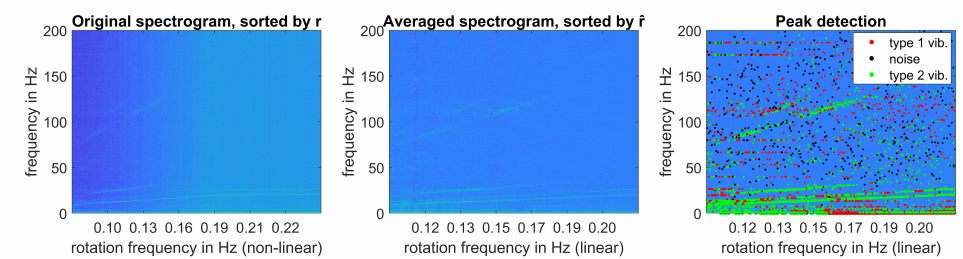
Figure 6. Processing for an exemplary sensor with f s = 400Hz and the rotation frequency f rot selected as reference variable. ( Left ) Non-linear-scale spectrogram with L M = 1640 single measurement campaigns. ( Middle ) Linear-scale spectrogram with linear grid of size L G = 163. ( Right ) Peak detection with N ˆ p , single = 15 peaks per grid point, peak assignment to Type 1 vibrations ( P v 1 ), noise ( P noise ) and peaks used for detecting Type 2 vibrations ( P v 2 + P rem ) as discussed in the subsequent analysis. Colours of spectrograms corresponding to amplitudes on a logarithmic